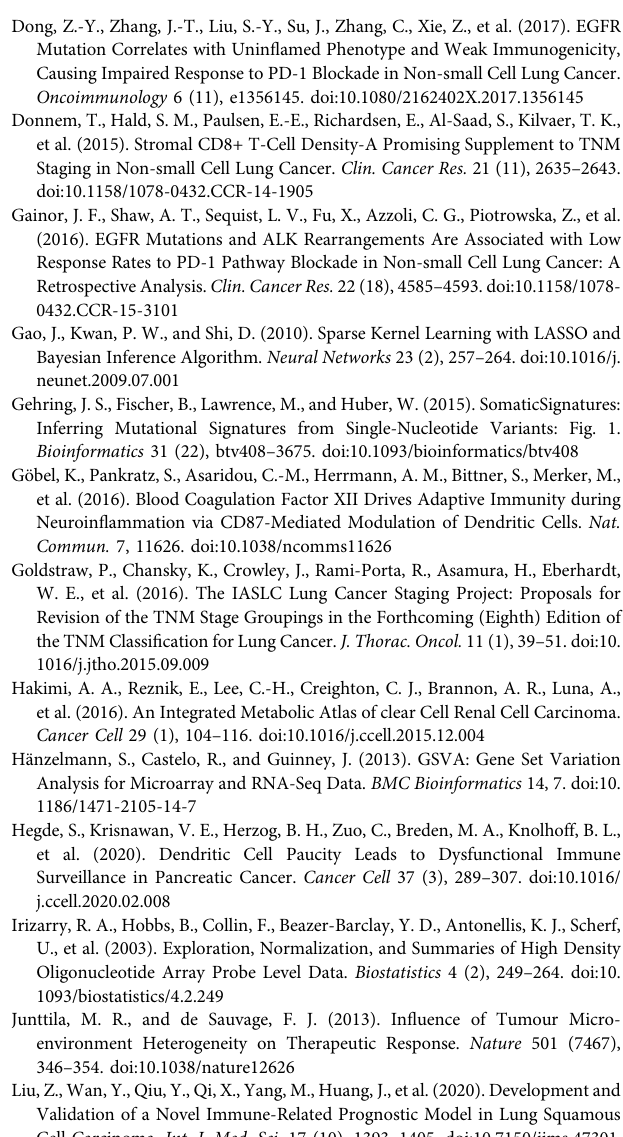
Supplementary Figure S6 | Construction of prognostic risk score (PRS) model analyzed byLASSOregressionandcomparisonofDFS,DSS,andPFSbetweenthe high- and low-risk patients in the training set. (A) Tuning parameter ( λ ) and deviance in the LASSO regression (left). The partial likelihood deviance was plotted versus log ( λ ). The dotted vertical lines were drawn at the optimal values by using the minimum and 1-SE criteria. Fourteen features with the smallest binomial deviance were selected. LASSO coef fi cient pro fi les of texture features (right). Each line represented a variable with the regression coef fi cient on the vertical axis and the logarithm of λ on the abscissa. A 10-fold cross-validation was used in the log ( λ ) sequence to select 14 variables with non-zero coef fi cients. (B) Comparisons of disease-free survival (DFS) (left), disease-speci fi c survival (DSS) (middle), and progression-free survival (PFS) (right) of high- and low-risk patients in the training set. (C) Time-dependent receiver operating characteristic curves of 3- and 5-year survival in the training set (left) and test set (right). Supplementary Figure S7 | Identi fi cation and comparison of de novo mutational signatures in the training set. (A) Upper image, residual sum of square (RSS) of the signature number selection. Lower image, percentage of variance explained in the signature number selection. (B) Cosine similarity between 30 cosmic signatures (horizontal axis) and 11 de novo signatures (vertical axis) in the training set. (C)